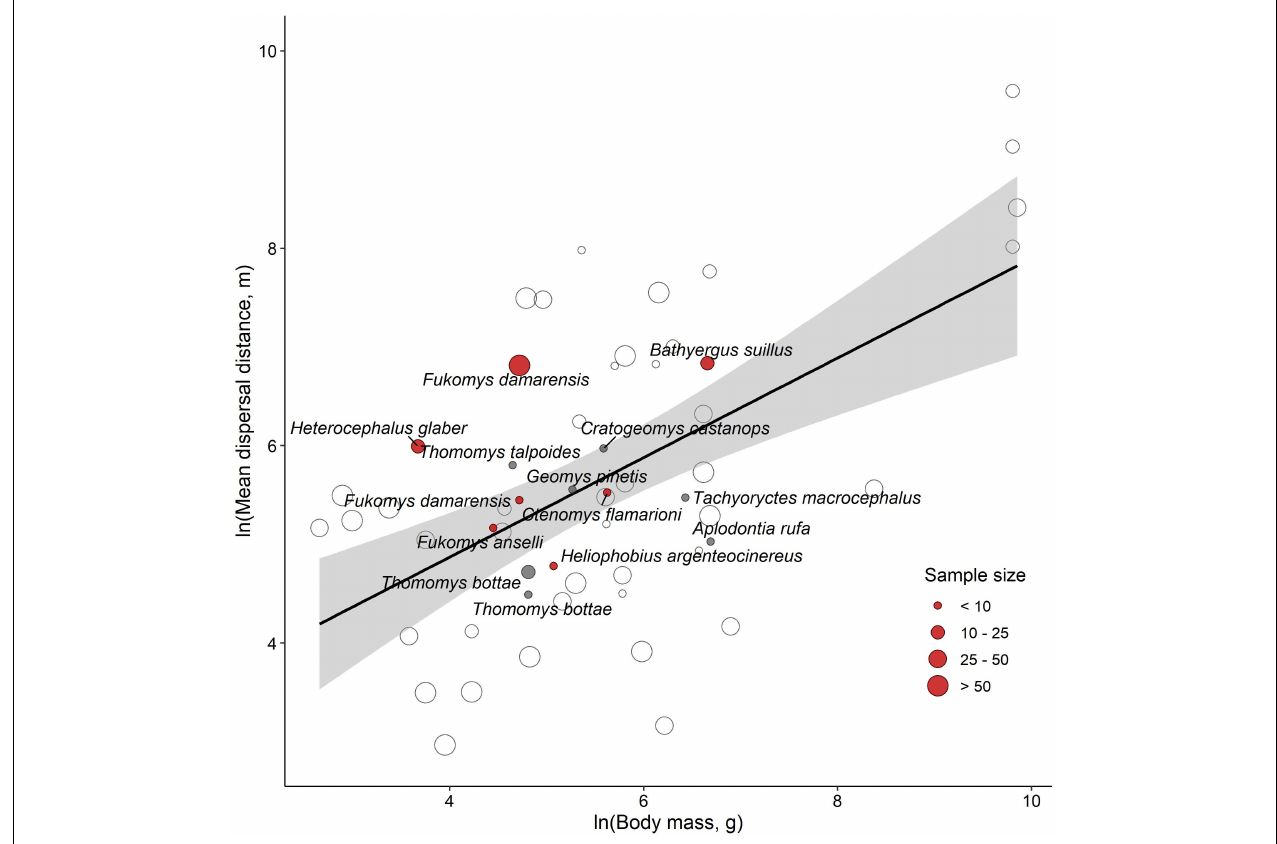
FIGURE 2 | The relationship between the mean dispersal distance and body mass in rodents. Data points are separated according to whether the species is subterranean (red), fossorial (gray), or surface-dwelling (clear). Points are sized according to the number of observed dispersal records in the literature review as shown in the legend. The large Fukomys damarensis circle is from this study. The solid line indicates the line of best fit through the raw data for surface-dwelling rodents with shading denoting the 95% confidence